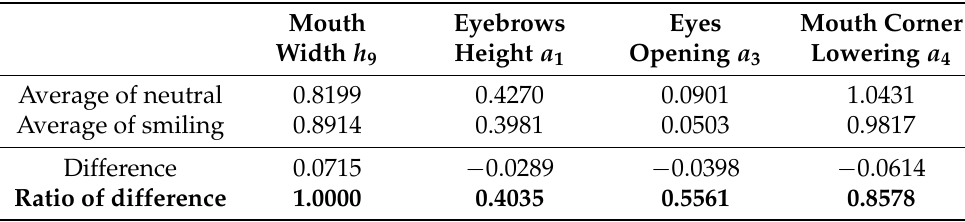
Table 1. Average of 10 feature values for the neutral and the smiling faces of the author.